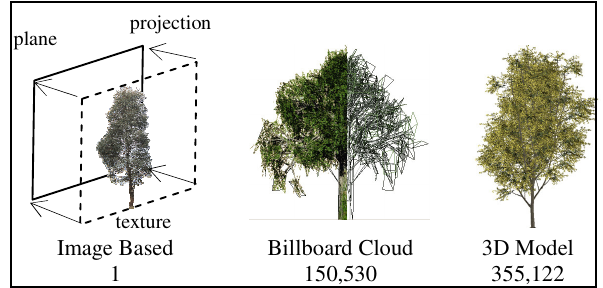
Figure 1. The three primary approaches to plant-based visualisation. The bottom numbers represent the numbers of polygons used to create each